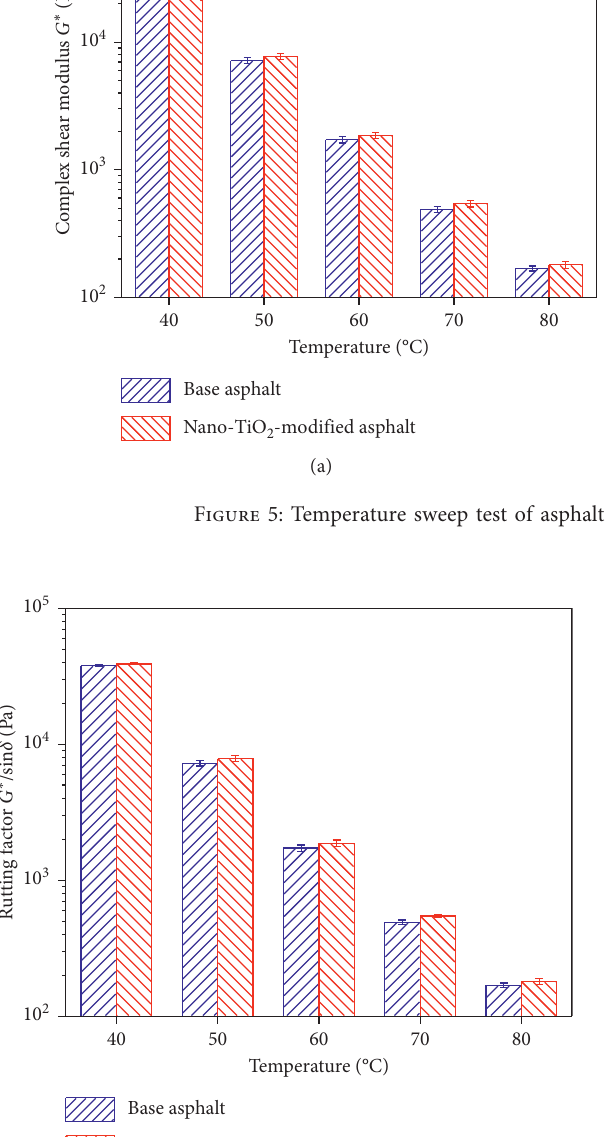
Figure 6: G ∗ /sin δ comparison